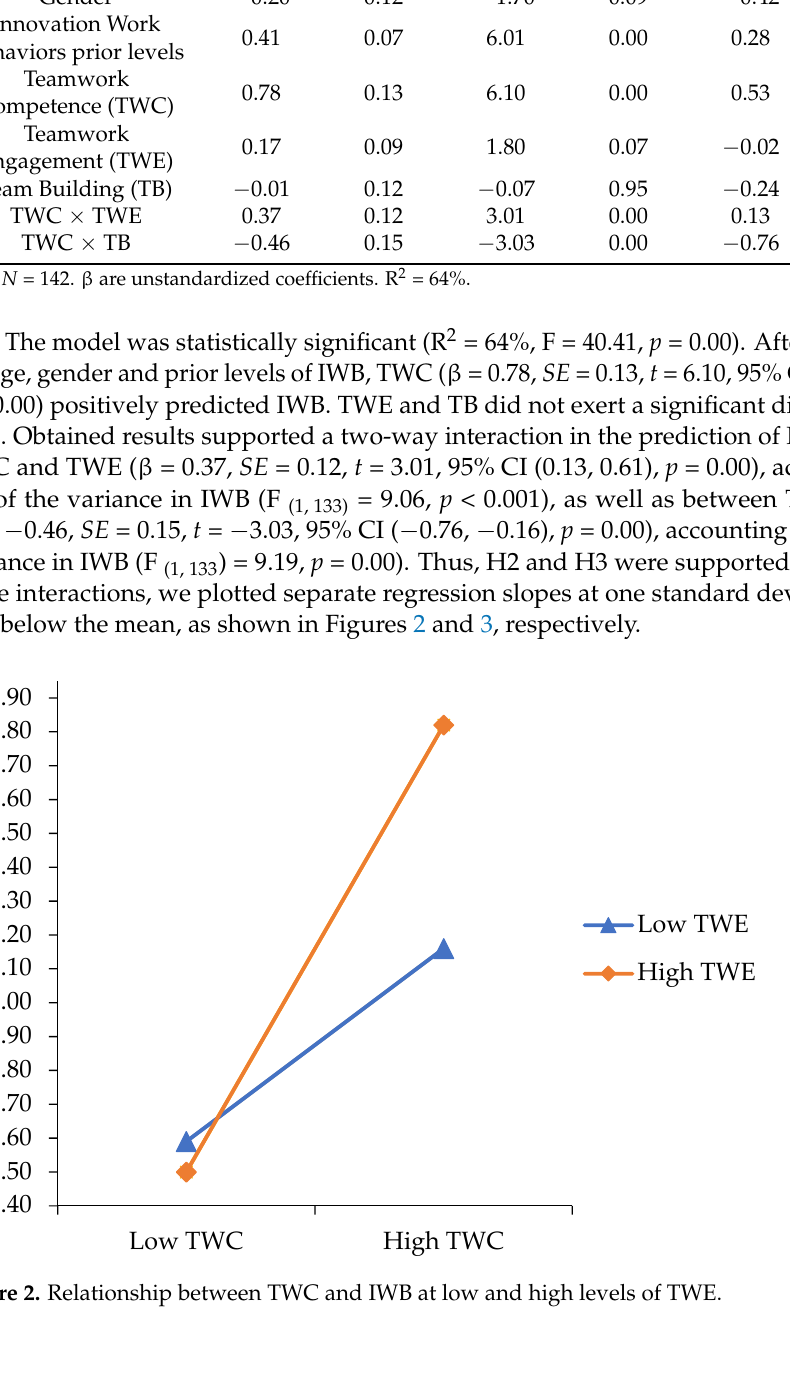
Figure 3. Relationship between TWC and IWB at low and high levels of TB. We found that TWE moderated the effect of TWC on IWB ( β = 0.37, SE = 0.12, t = 3.01, 95% CI (0.13, 0.61), p = 0.00). As we noted, to interpret this interaction, we plotted separate regression slopes at two levels of TWE: low (i.e., 1 SD below the mean) and high (i.e., 1 SD above the mean) in Figure 2. At low levels of TWE, IWB increased as college students developed higher levels of TWC. At high levels of TWE, we found a similar pattern. These results indicated that TWC is more strongly associated with IWB when TWE is high.